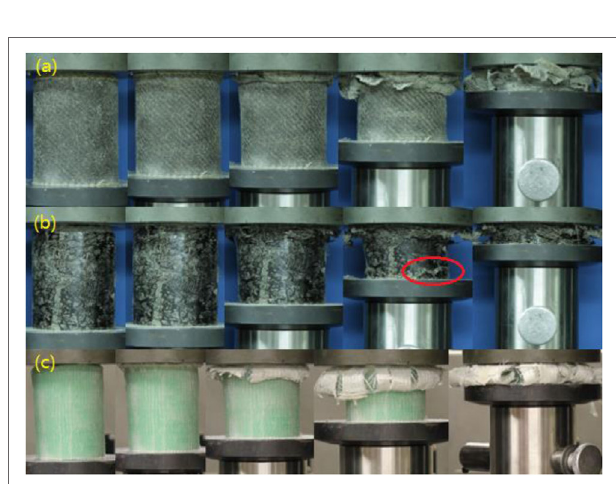
FigUre 9 | Axial crushing load vs. displacement of hollow and foam-filled basalt FRP (BFRP) tubes.